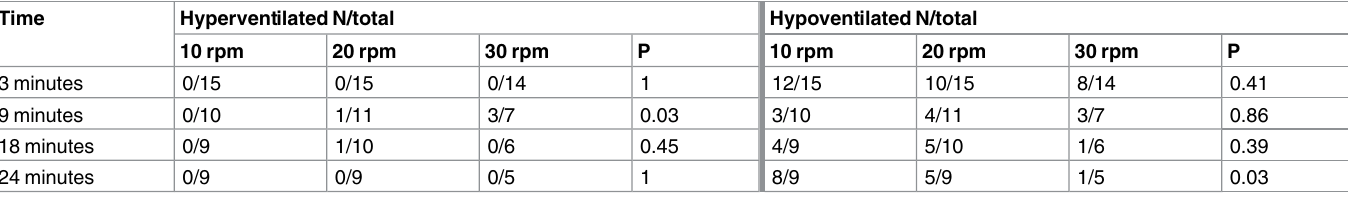
slightly higher MAP than those ventilated with 10 rpm. This fact supports previous results from this same animal model showing that CPR with ventilation as opposed to chest compres- sions only does not negatively affect haemodynamics during CPR [6,7]. Although MAP depends more on compressions quality than on RR, higher RR achieve better systemic and Table 2. Hyper (PaCO 2 < 30 mmHg)and hypoventilated (PaCO 2 > 50 mmHg)pigletsbetween the 3 groups alongthe hole resuscitation. Time HyperventilatedN/total